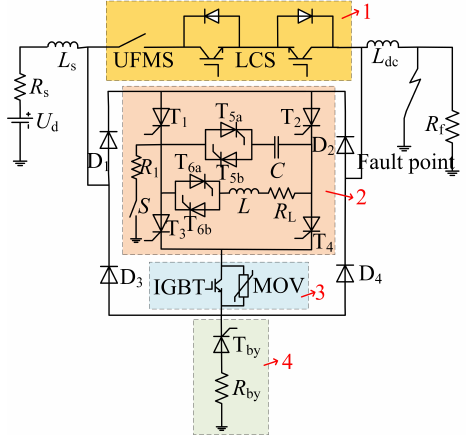
Fig. 1. RFL-HDCCB topological